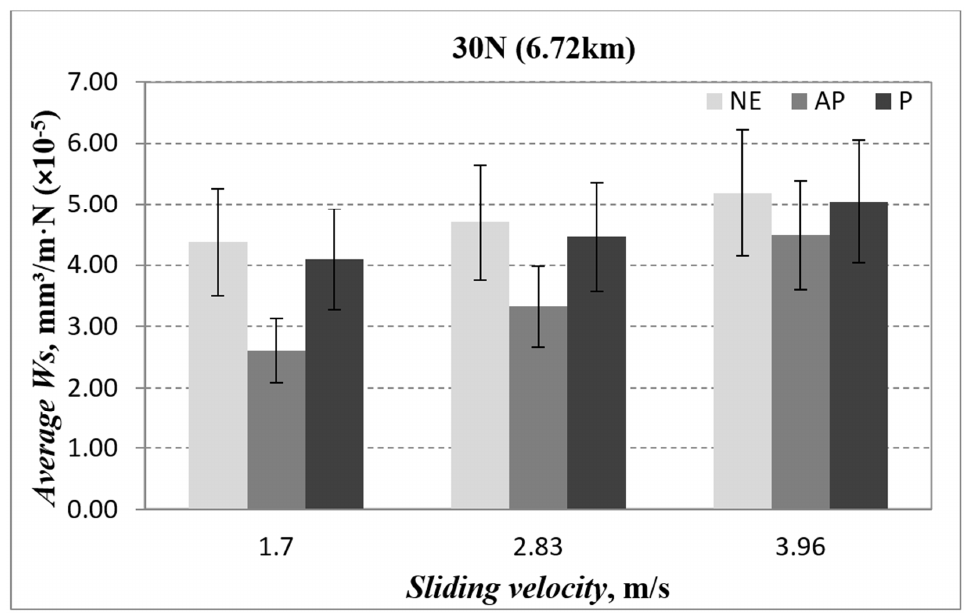
Figure 8. Average specific wear rate vs. sliding velocity for different fibre orientation (AP and P) and neat epoxy subjected to an applied normal load of 30 N at different of sliding